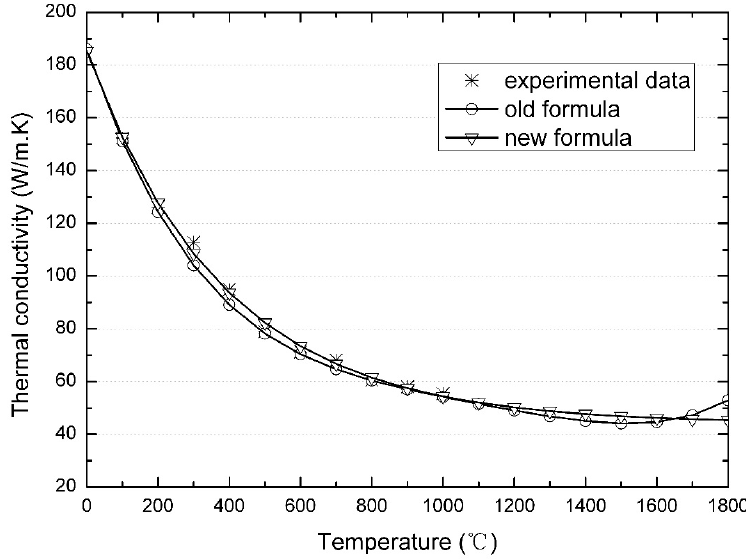
Figure 9. Comparison of the old and new fitting formula of the heat conductivity of the pebble material.